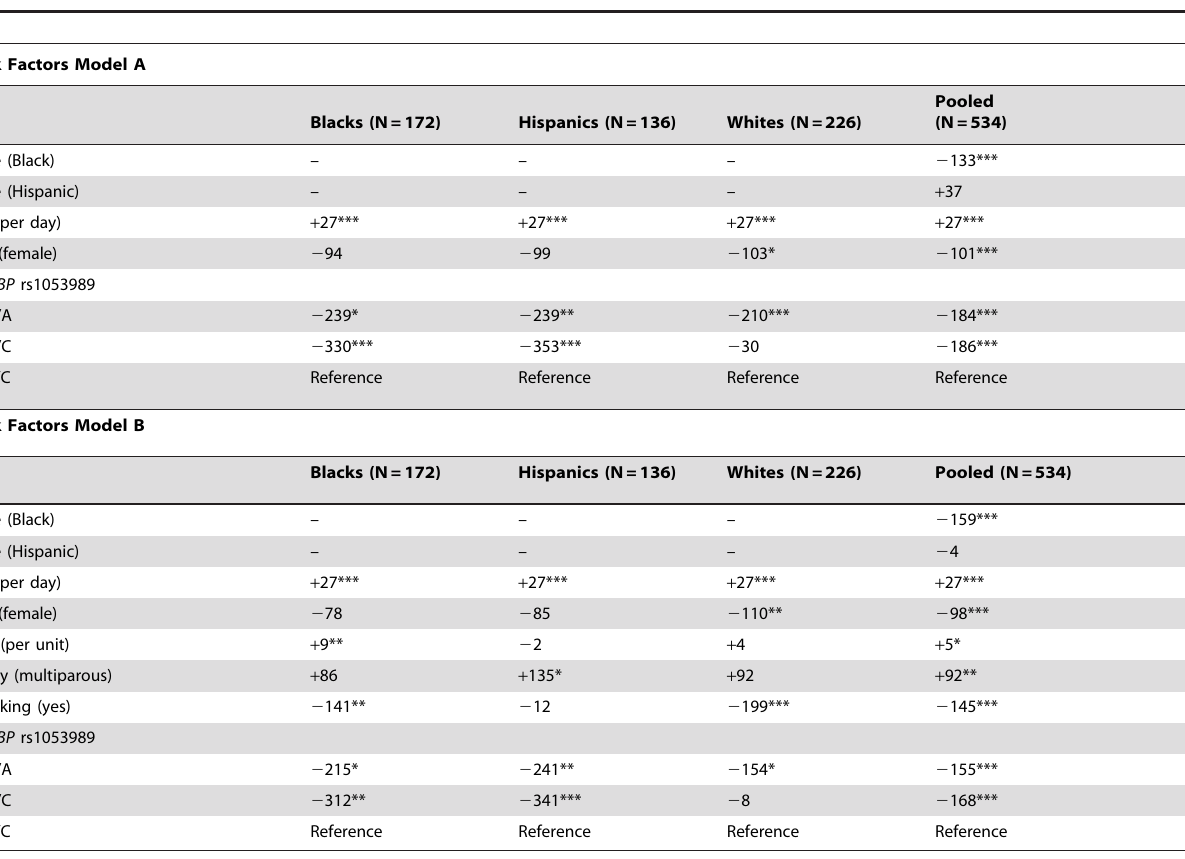
Table 5. Estimates of effects of mother’s risk factors and mother’s genotype (CRHBP SNP rs1053989) on infant birth weight in